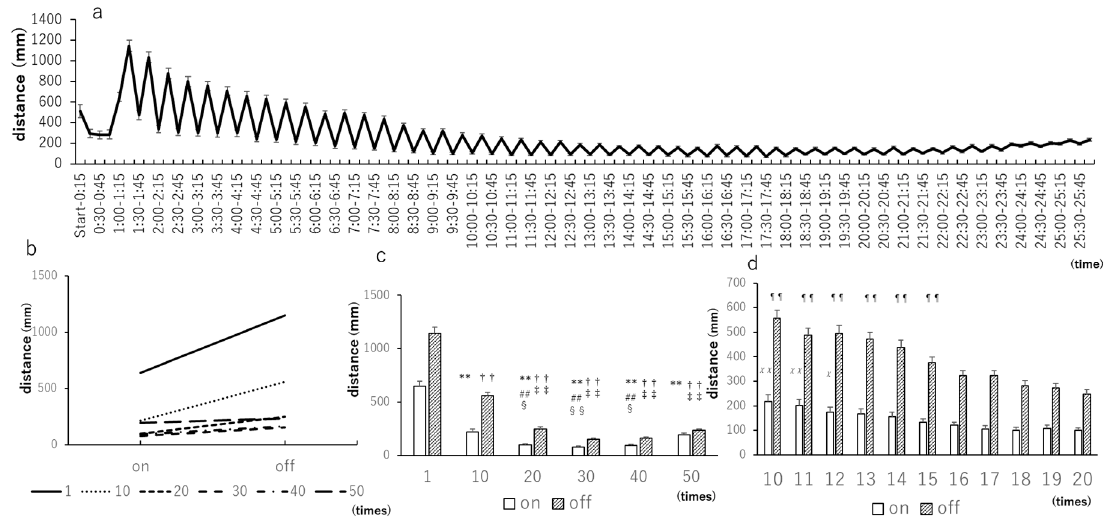
Figure 1. Light–dark test with 15-min intervals repeated 50 times. ( a ) Distance traveled by zebrafish larvae when light and dark stimuli were alternately repeated 50 times at 15-min intervals after being acclimated to a dark place for 1 h. As the number of repetitions increases, the traveled distance becomes smaller and more constant; ( b ) Distance traveled when the light is on and off at arbitrary numbers of repetitions (1st, 10th, 20th, 30th, 40th, and 50th). At all points, the traveled distance is larger when the light is off than when the light is on. After the 20th repetition, there are almost no changes in the traveled distance; ( c ) Tukey–Kramer test results; ( d ) Dunnett’s test results, where the 10th to 20th repetitions were extracted and tested with the 20th repetition as reference. * p < 0.05 vs. 1 (on), ** p < 0.01 vs. 1 (on), # p < 0.05 vs. 10 (off), ## p < 0.01 vs. 10 (off), § p < 0.05 vs. 50 (on), §§ p < 0.01 vs. 50 (on), † p < 0.05 vs. 1 (o ff ), †† p < 0.01 vs. 1 (off), ‡ p < 0.05 vs. 10 (off), ‡‡ p < 0.01 vs. 10 (off), χ p < 0.05 vs. 20 (on), (Tukey–Kramer test). χ χ p < 0.01 vs. 20 (on), ¶¶ p < 0.01 vs. 20 (off), (Dunnett’s test). Values are presented as mean ± SE ( n = 47).